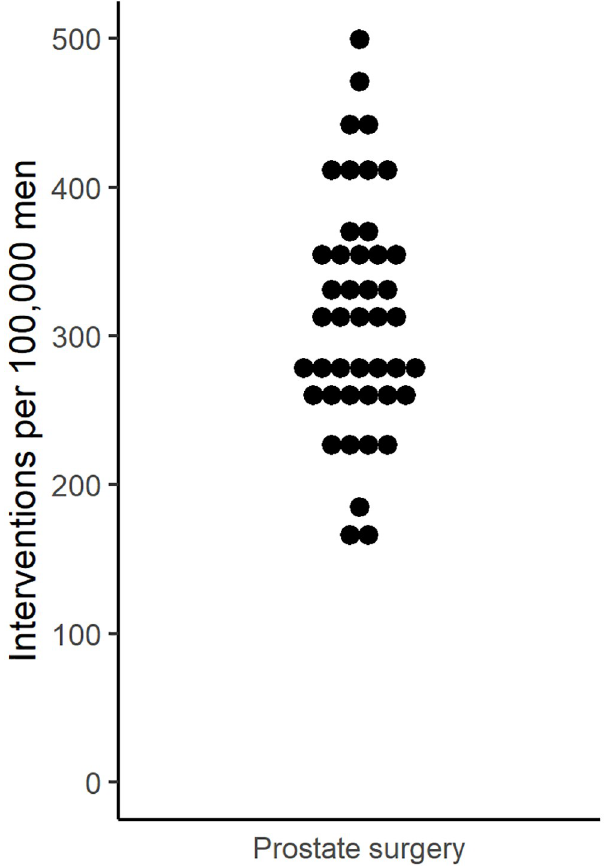
Fig 2. Variation in age-standardized prostate surgery rates across 44 Swiss Hospital Service Areas. Each dot represents a Hospital Service Area.